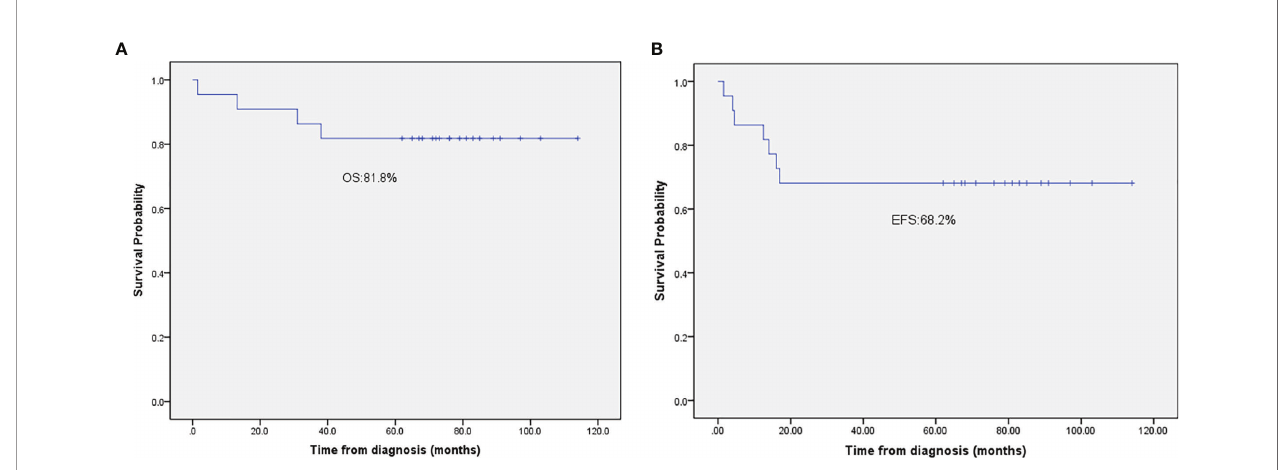
FIGURE 1 | (A) The 5-year overall survival rate of patients with advanced-stage ALCL. (B) The 5-year event-free survival rate of patients with advanced-stage